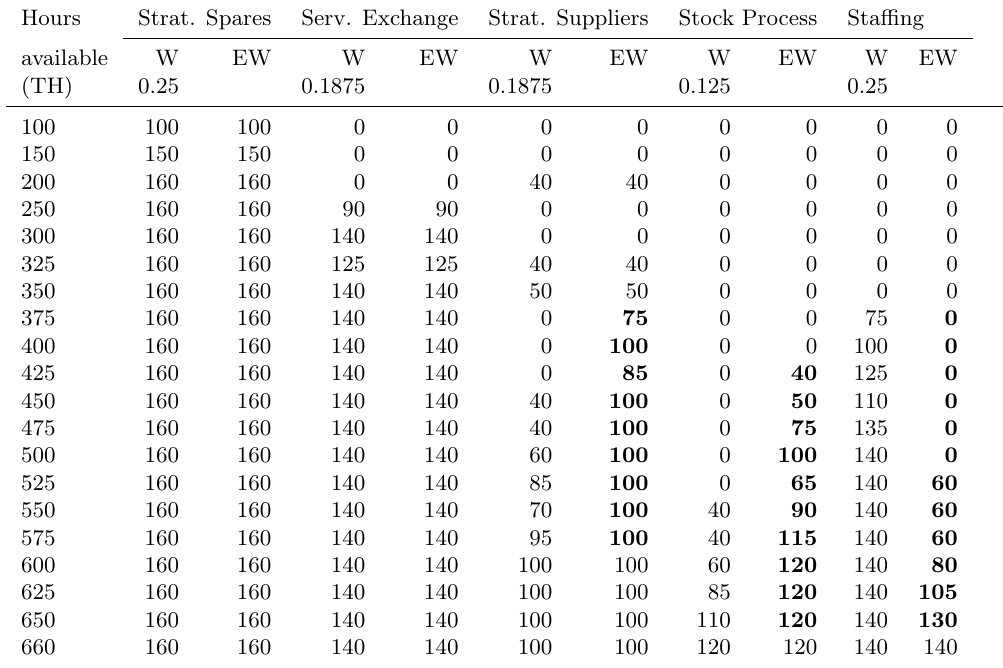
Table 6: Goal programming model results. In the column headings W denotes weight and EW denotes equal